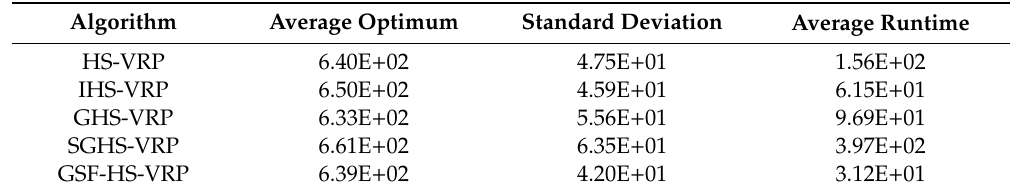
Table 4. Comparison results at fixed iteration times. Table 4 Comparison results at fixed iteration times.